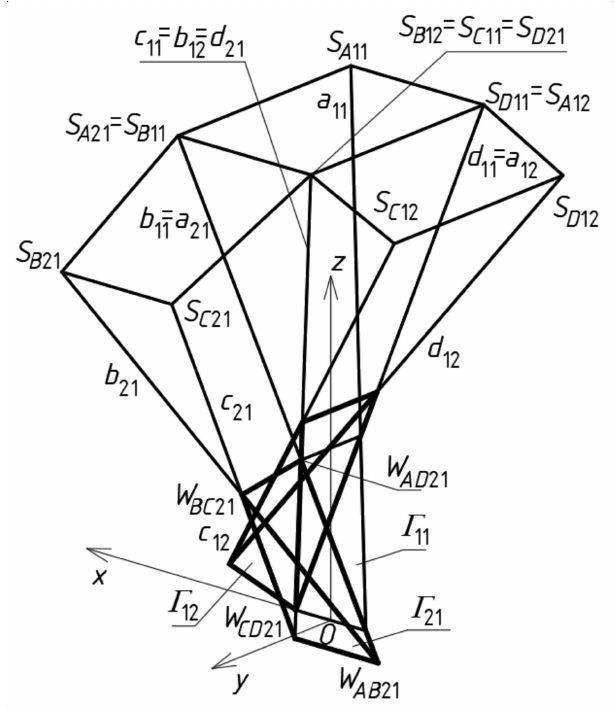
Figure 13. Subsequent tetrads of the points belonging to Γ 21 . At the end of this step, four auxiliary points f the ω r reference surface are determined on the side edges of Γ 22 . Three of these points are determined on a 22 = b 12 , b 22 = c 21 , and d 22 = c 12 , so that S A 22 = S B 12 , S B 22 = S C 21 and S D 22 = S C 12 (Figure 14). The last one belongs to c 22 determined by W CD 22 and W BC 22 , using a division coefficient constituting one element of the fourth set of the initial data.